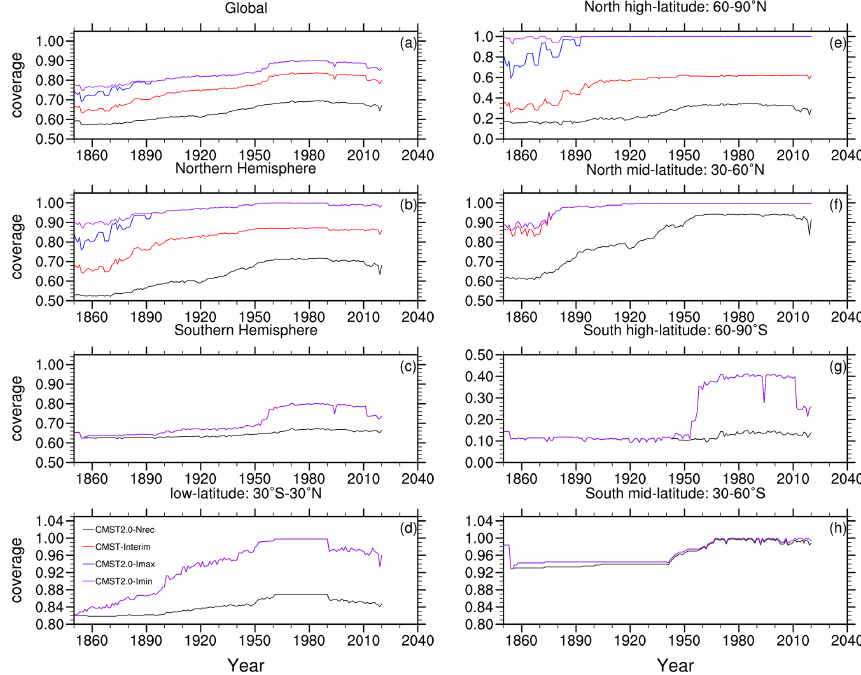
Figure 5. Coverage comparison of CMST 2.0 − Nrec, CMST-Interim, CMST 2.0 − Imax, and CMST 2.0 − Imin.